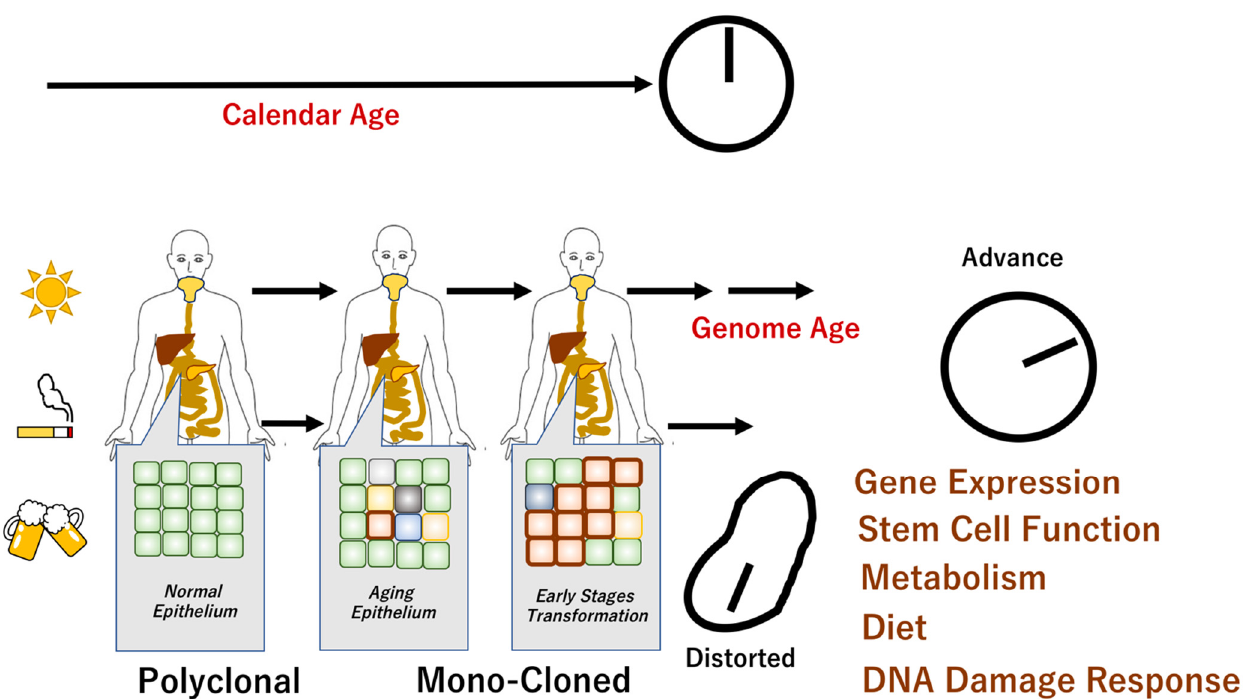
Figure 1. Genome aging and chronological age. It has been shown that there are individuals whose chronological age does not correspond to their biological age. Aging is associated with genomic changes over time, although the specific aging phenotype is influenced by complex internal and external mechanisms. Recent studies revealed that apparently normal epithelium demonstrated polyclonal features. The epithelial monoclonal characteristics underwent cellular transformation that may facilitate carcinogenesis [4,17]. The scheme denotes the mechanisms of chronological age in normal cells and distorted molecular events in cancer cells.